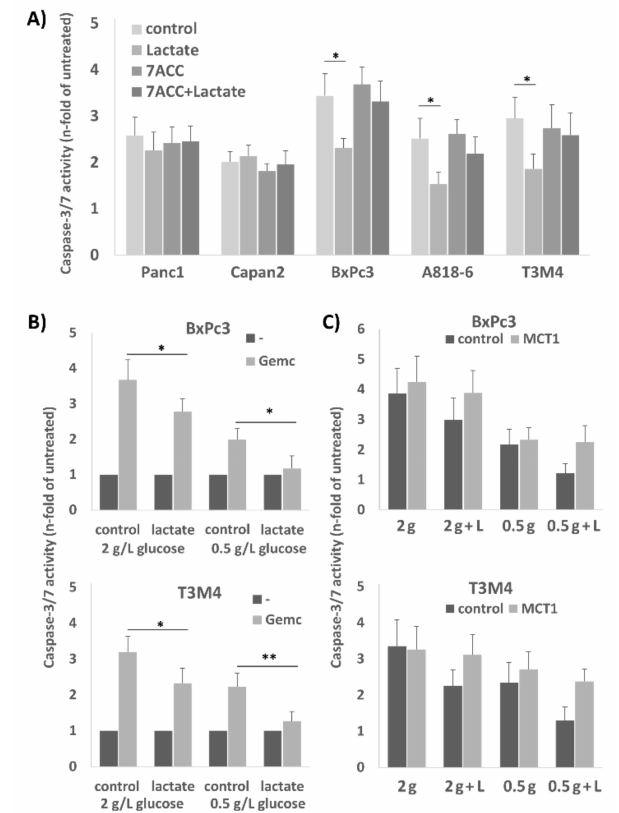
Figure 3. MCT1-driven lactate import protects human PDAC cell lines from anti-cancer drug-induced apoptosis. ( A ) Using the PDAC cell lines A818-6, BxPc3, and T3M4 exhibiting high MCT1